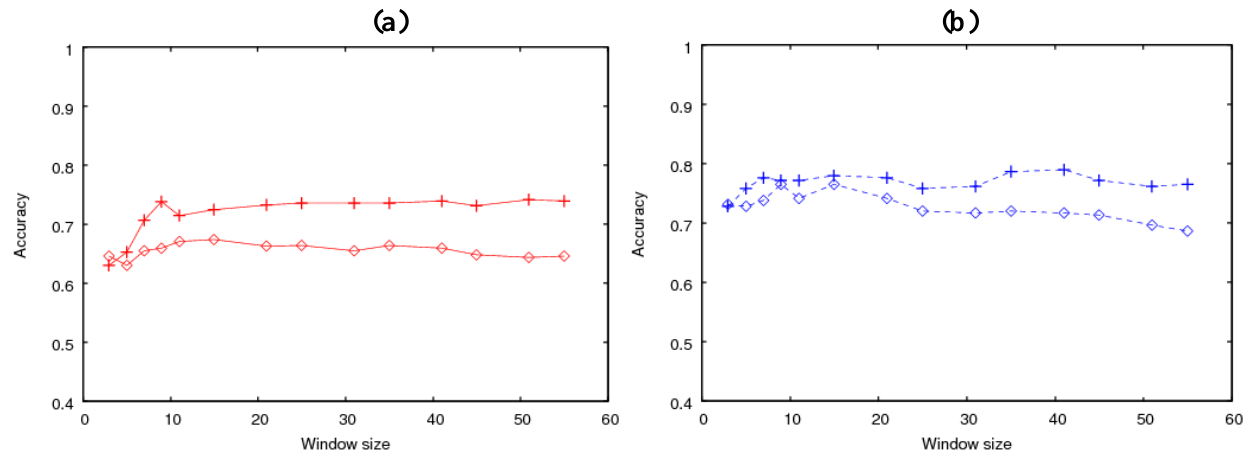
Figure 2. ( a ) Prediction accuracies of the two SVMs for the clustered glycosylation. The crosses and circles represent the prediction obtained using the SVM trained by the clustered and isolated type, respectively. The input was the sequence information. (b ) Prediction accuracies of the two SVMs for the isolated glycosylation. The crosses and circles represent the prediction obtained using the SVM trained by the isolated and clustered type,